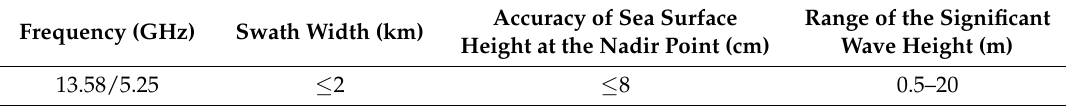
Table 1. The detailed information of the radar altimeter of HY-2A.